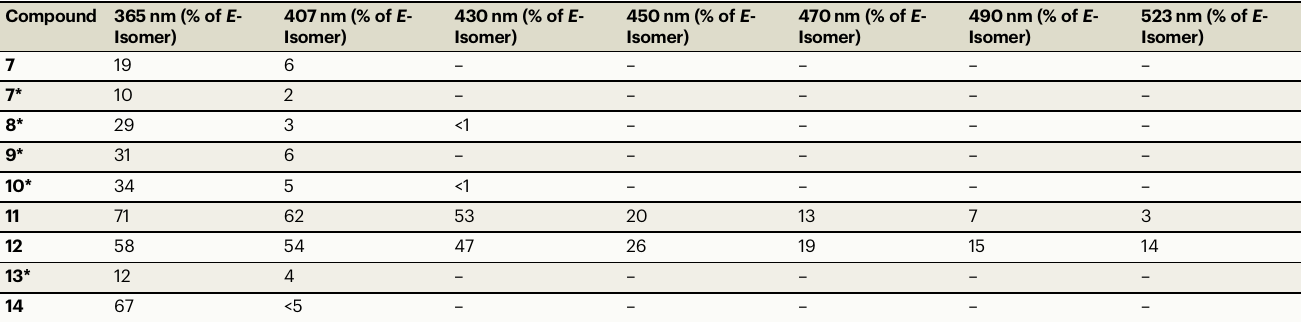
Collecteddatafromthe 1 HNMRdeterminationofthe E/Z -isomerratiooftherespectivecompounds( 7-14 )uponirradiationwiththeindicatedwavelengthsoflightuntilequilibrium(PSS),basedon individually collected data foreach ofthe compounds,depicted on theSupplementaryFigs. 40 – 48. *in CD 2 Cl 2 , otherwisein DMSO- d 6